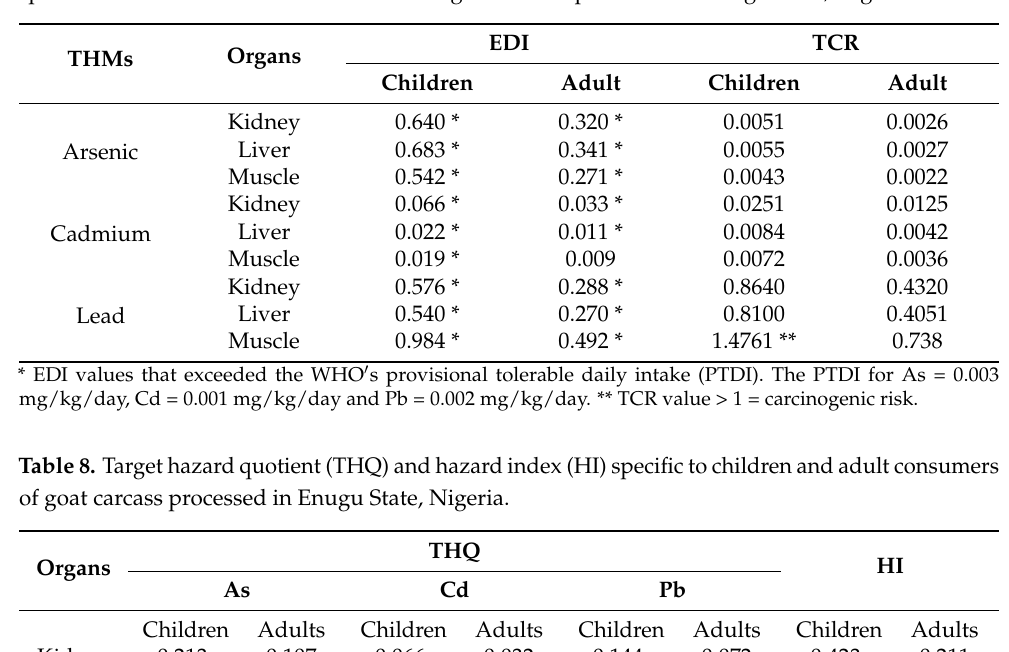
Table 7. Estimated daily intake (EDI) and target cancer risk (TCR) of toxic heavy metals (THMs) specific to children and adult consumers of goat carcass processed in Enugu State, Nigeria.